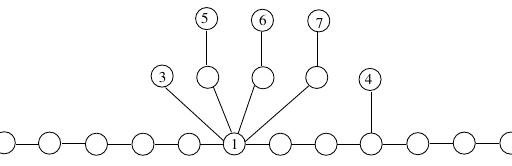
Figure 3: A tree T